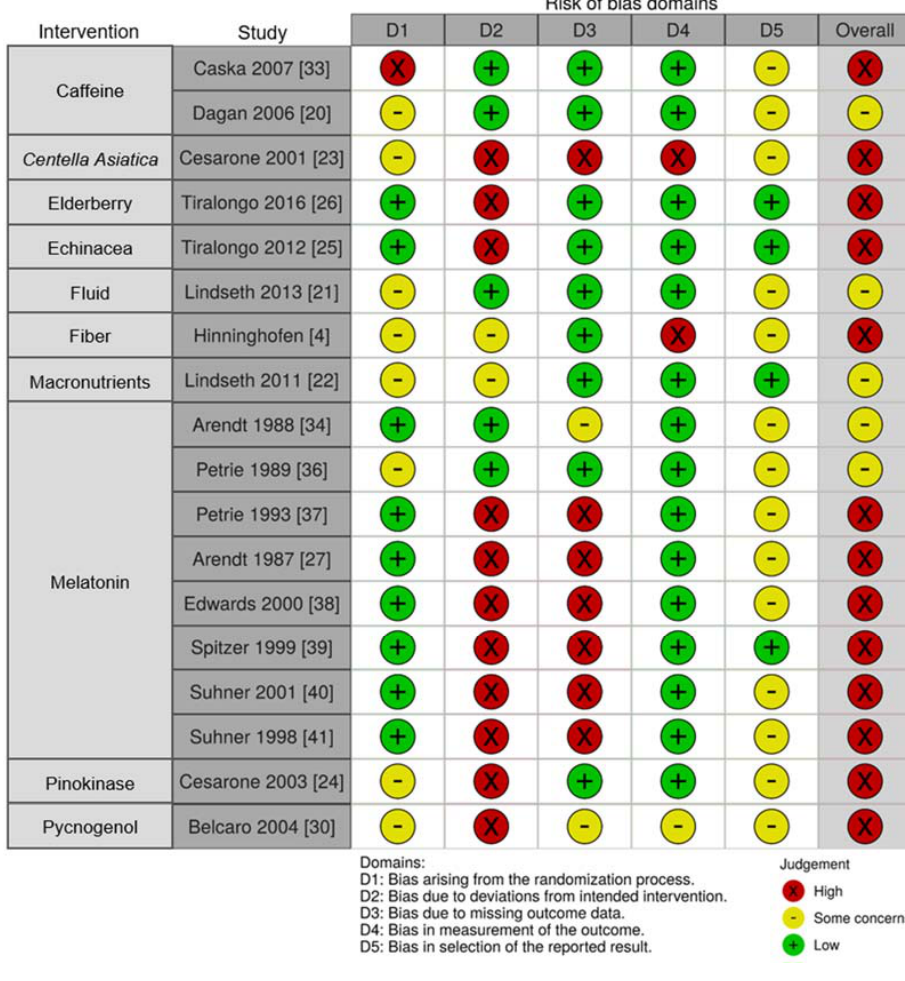
Figure 5. Risk of bias of randomized controlled trials assessed using Cochrane’s Rob-2 Tool presented according to the intervention agent as indicated [4,20–27,30,33,34,36–41].